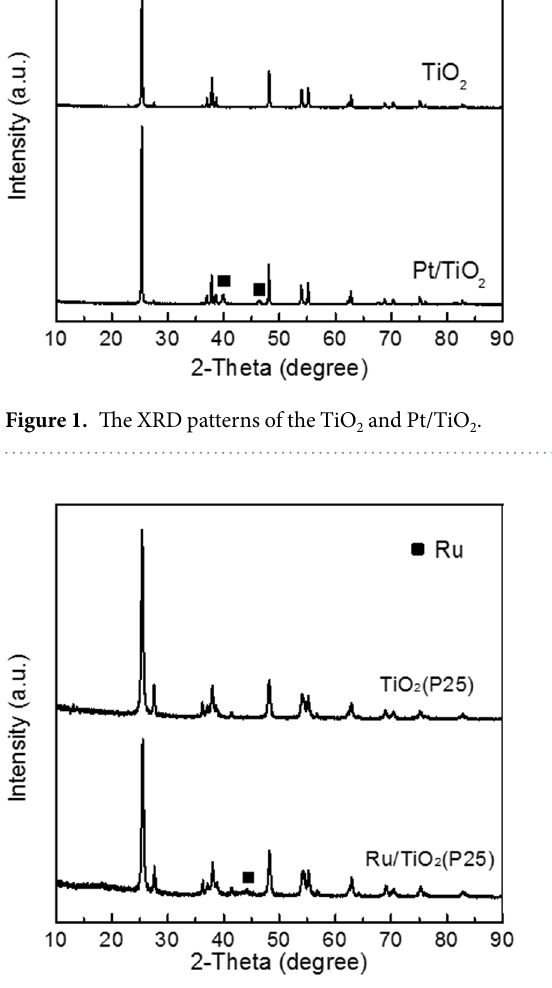
Figure 2. The XRD patterns of the TiO 2 and Ru/TiO 2